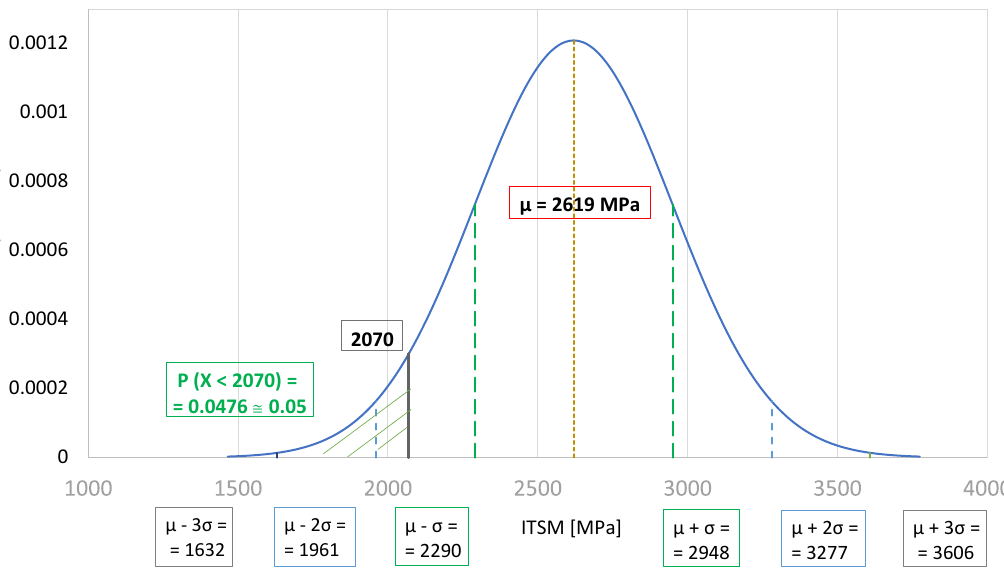
Figure 9. Probability density function of a normal distribution N (2619; 329) for ITSM values at 20 °C.